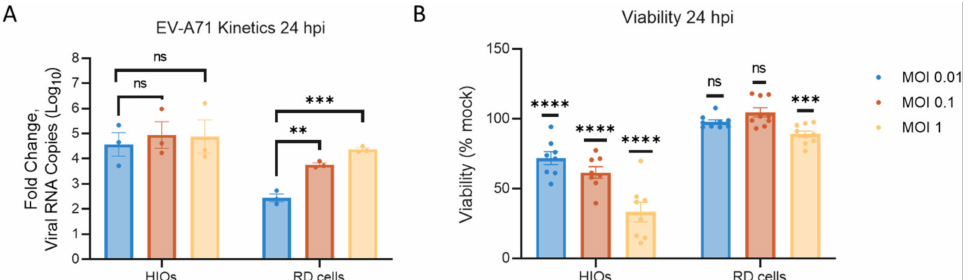
Figure 2. Comparison of EV-A71 replication kinetics between HIOs and RD cells. ( A ) EV-A71 replication kinetics 24 hpi. HIOs and RD cells were infected with EV-A71 virus at 0.01, 0.1, and 1 MOI. Total culture of HIOs and supernatant of RD cells were collected by combining triplicates and measured for viral RNA yield by RT-qPCR, and fold change is calculated based on mock infection. ( B ) Viability 24 h post EV-A71 infection. Viability in HIOs and RD cells was measured using Cell Titer-Glo 3D or Cell Titer-Glo, respectively. Mock-infected HIOs/cells were used to normalize the